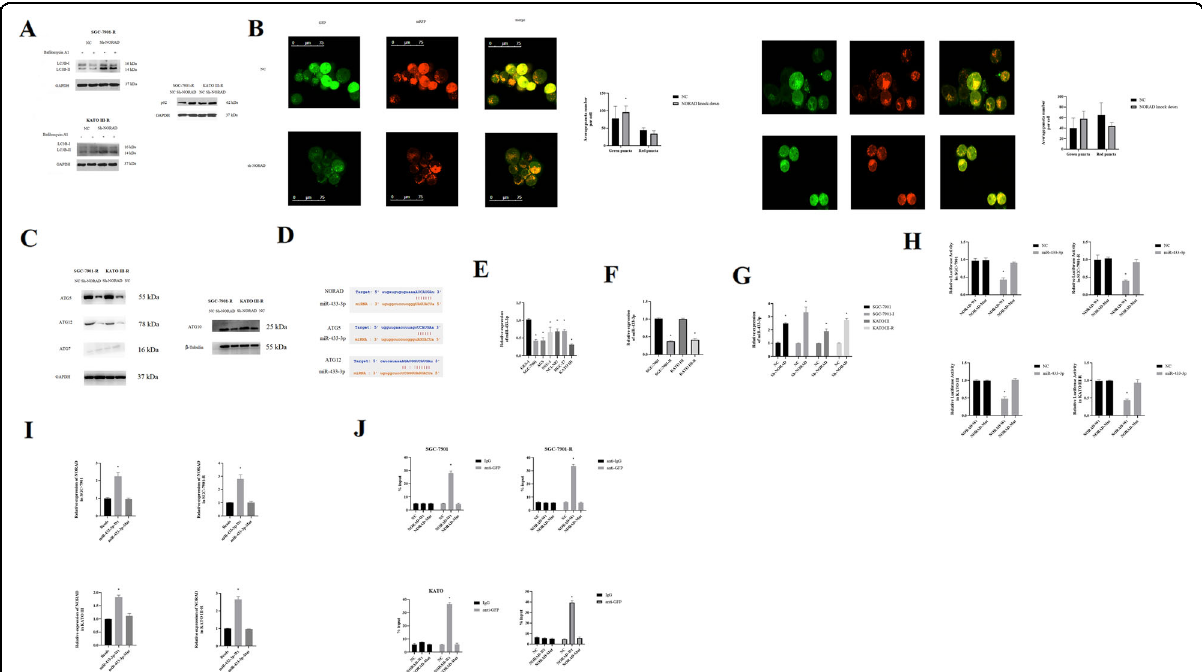
Fig. 6 miR-433-3p was the downstream target of NORAD to regulate autophagy. A LC3B I/II expression in NORAD knockdown SGC-7901-R and KATO III-R cells: LC3B I/II 16/14 kDa, p62 62 kDa, GAPDH 37 kDa. B Autophagy fl ux was decreased by knocking down NORAD (SGC-7901-R, t = 4.241, P = 0.043; KATO III-R, t = 3.992, P = 0.036) C Expression of autophagy-related genes in NORAD knockdown SGC-7901-R and KATO III-R cell line: ATG5 (ATG5-ATG12 complex) 55 kDa, ATG12(free ATG12) 16 kDa, ATG 78 kDa, GAPDH 37 kDa, ATG10 25 kDa, β -Tubulin 55 kDa. D Starbase prediction for the binding site of NORAD to miR-433-3p; and Starbase prediction for the binding site of miR-433-3p to ATG5 and ATG12. E qRT-PCR to detect the expression of miR-433-3p in gastric cancer compared with GES-1. One-way ANOVA: GES-1 vs SGC-7901, q = 10.37, P < 0.000; GES-1 vs AGS, q = 10.26, P < 0.000; GES-1 vs SNU-1, q = 6.274, P = 0.000; GES-1 vs HGC-27, q = 5.816, P = 0.000; GES-1 vs KATO III, q = 12.27, P < 0.000. F qRT-PCR to detect the expression of miR-433-3p in SGC-7901-R compared with SGC-7901 and KATO III-R compared with KATO III (SGC-7901 vs SGC-7901-R, t = 40.75, P = 0.000; KATO III vs KATO III-R, t = 23.00, P = 0.000). G qRT-PCR to detect the in fl uence of NORAD knockdown on the expression of miR-433-3p in SGC- 7901, SGC-7901-R, KATO III, and KATO III-R. (SGC-7901, t = 10.72, P < 0.000; SGC-7901-R, t = 17.31, P < 0.000; KATO III, t = 6.778, P < 0.000; KATO III-R, t = 12.98, P < 0.000). H Dual-luciferase reporter gene assay for NORAD and miR-433-3p (NORAD-Wt vs NORAD-Mut in miR-433-3p group: SGC-7901, t = 10.76, P < 0.000; SGC-7901-R, t = 7.986, P < 0.000; KATO III, t = 6.778, P < 0.000; KATO III-R, t = 12.98, P < 0.000). I RNA pull-down assay for the expression of NORAD in miR-433-3p-Wt and miR-433-3p-Mut group in SGC-7901, SGC-7901-R, KATO III, and KATO III-R (miR-433-3p-Wt vs miR-433-3p -Mut: SGC-7901, t = 9.321, P = 0.001; SGC-7901-R, t = 8.962, P = 0.001; KATO III, t = 10.60, P = 0.000; KATO III-R, t = 19.07, P = 0.000). J RIP assay to detect the enrichment of miR-433-3p (NORAD-Wt vs NORAD-Mut: SGC-7901, t = 32.111, P = 0.000; SGC-7901-R, t = 15.12, P = 0.000; KATO III, t = 24.21, P = 0.000; KATO III-R, t = 13.22, P =